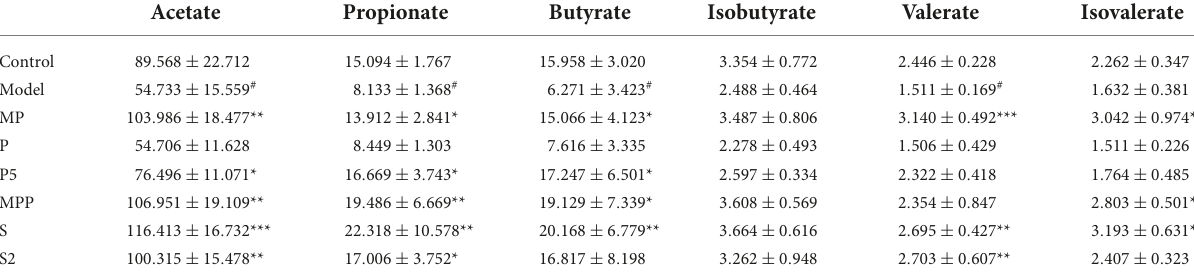
TABLE 3 Fecal SCFA concentration in different groups